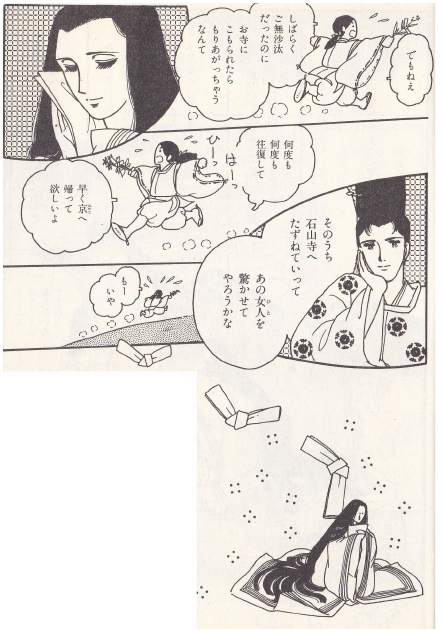
Figure 6. A boy delivers a letter between the capital and Ishiyama-dera (Kosakabe and Tanaka, Manga Izumi Shikibu nikki , 1990), 171. Courtesy of Heibonsha.